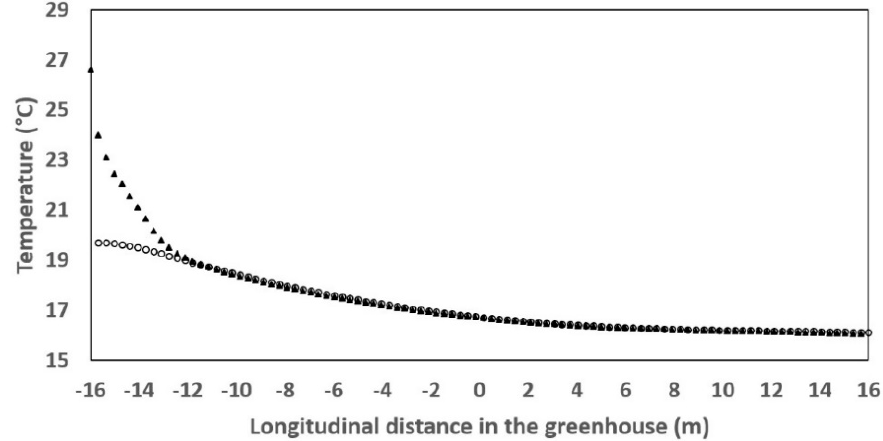
Figure 7. Distribution of temperatures (°C) at 0.7 m high in span 1 of the greenhouse for scenarios f ( ° ) and g ( ▲ ), with a 30 °C constant temperature supplied by the